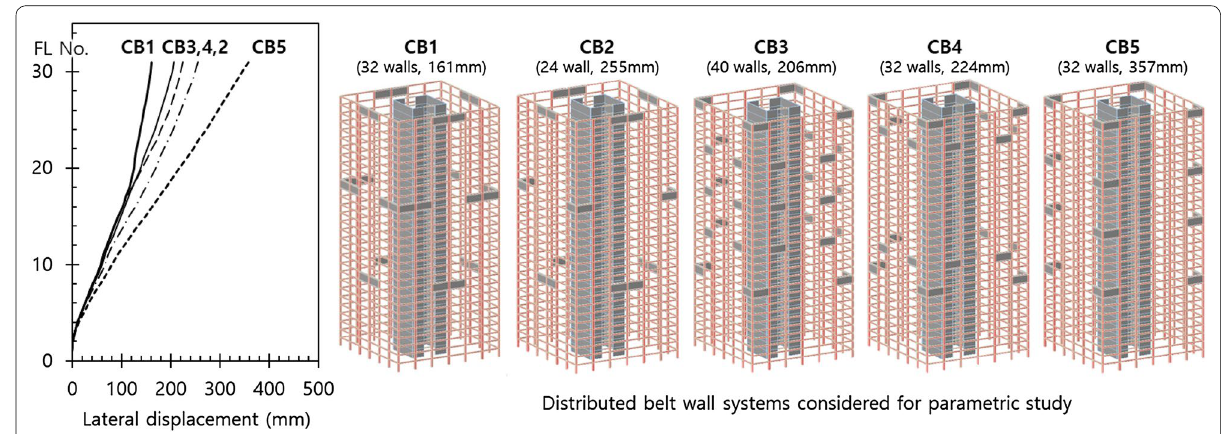
Fig. 6 Distributed belt wall systems as lateral force‑resisting structure system of concrete high‑rise